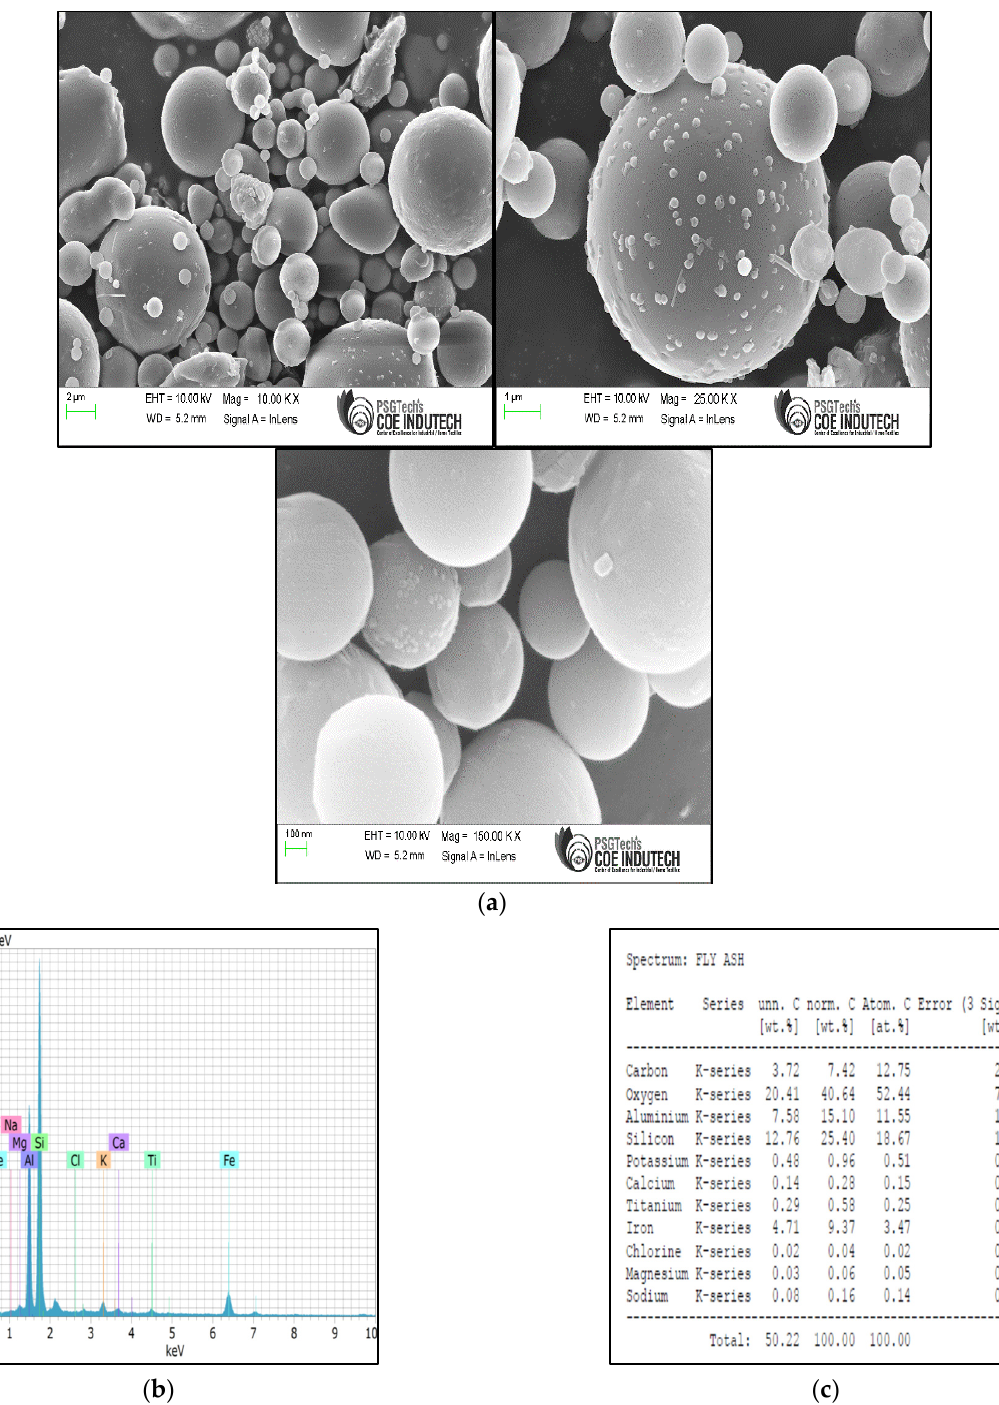
Figure 3. ( a ) Field emission scanning electron microscope images of fly ash. ( b , c ) Energy dispersive X-ray analysis images of fly ash.